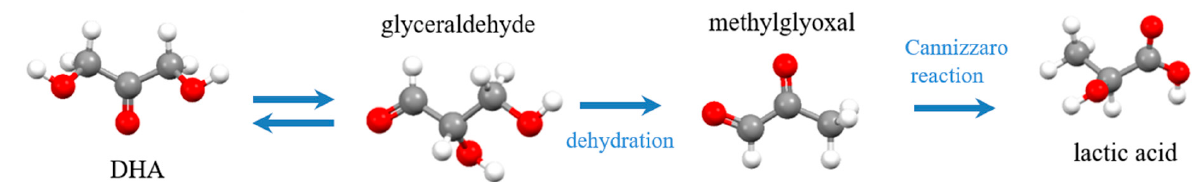
Figure 2. Scheme of reaction pathways of DHA and glyceraldehyde into methylglyoxal and lactic acid. Lactic acid (LA), ethyl lactate (EL) and pyruvic acid (PAC) are valuable compounds,